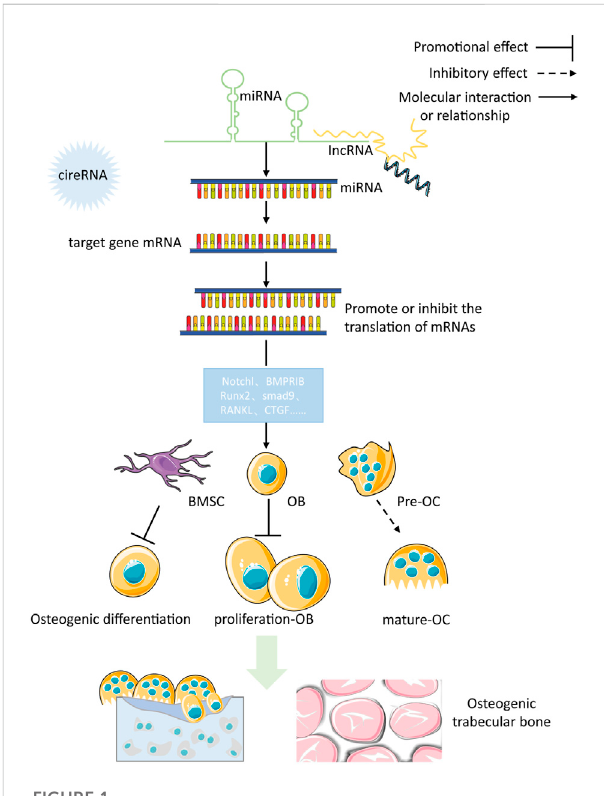
FIGURE 1 The speci fi c process of Wnt/ β -catenin signaling pathway in bone